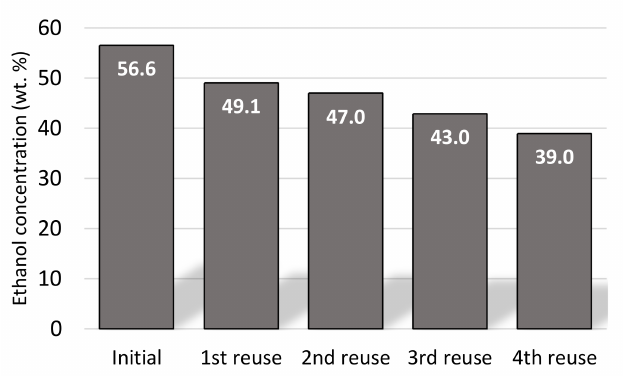
Figure 2. Concentrations of reuse ethanol using